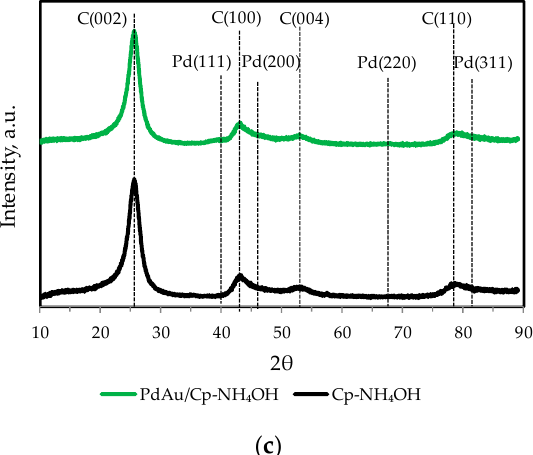
Figure 3. XRD patterns for catalysts PdAu/Cp ( a ), PdAu/Cp-HNO 3 ( b ) and PdAu/Cp-NH 4 OH ( c ) and their corresponding supports.